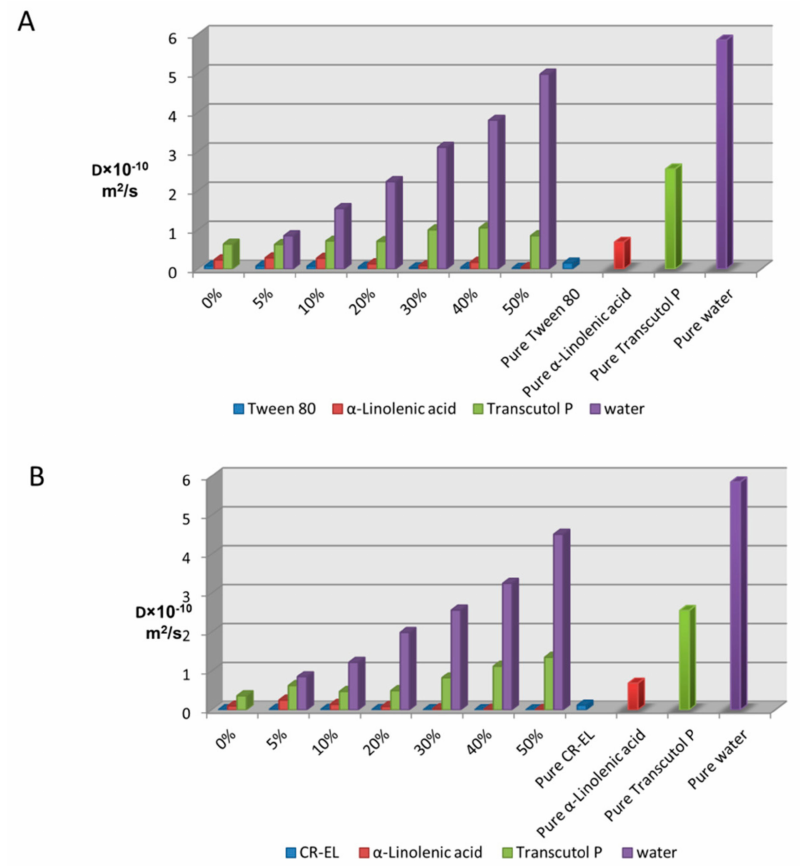
Figure 6. The self-diffusion coefficients of each component in α -Linolenic acid/water/Tween 80:Transcutol P(1:1) systems containing various concentrations of water from 0 to 50% ( w / w ) ( A ) and each component in α -Linolenic acid/water/CR-EL:Transcutol P(4:1) systems containing various concentrations of water from 0 to 50% ( w / w ) ( B